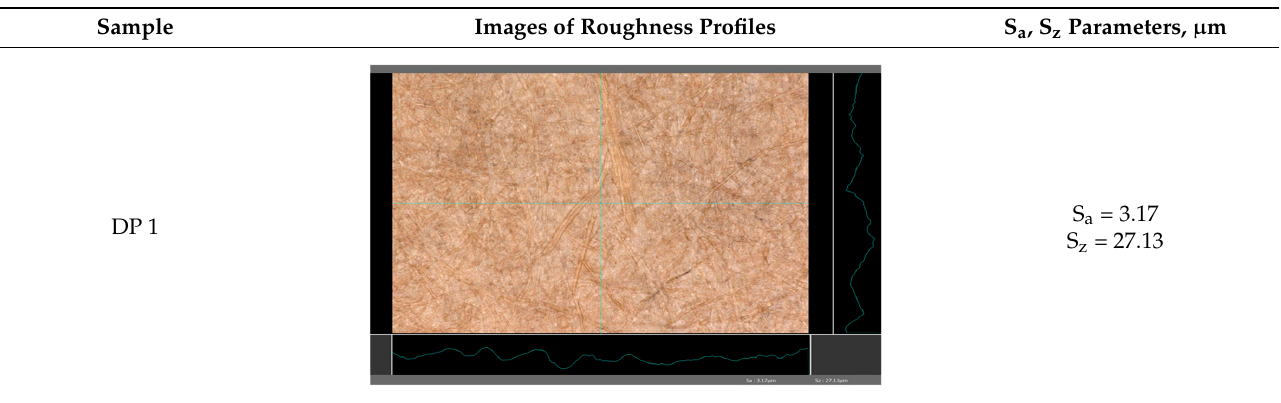
Table 5. Roughness profiles of the coated surface of the paper. DP—papers coated with paraffin-based dispersions, DB—papers coated with beeswax-based dispersions.